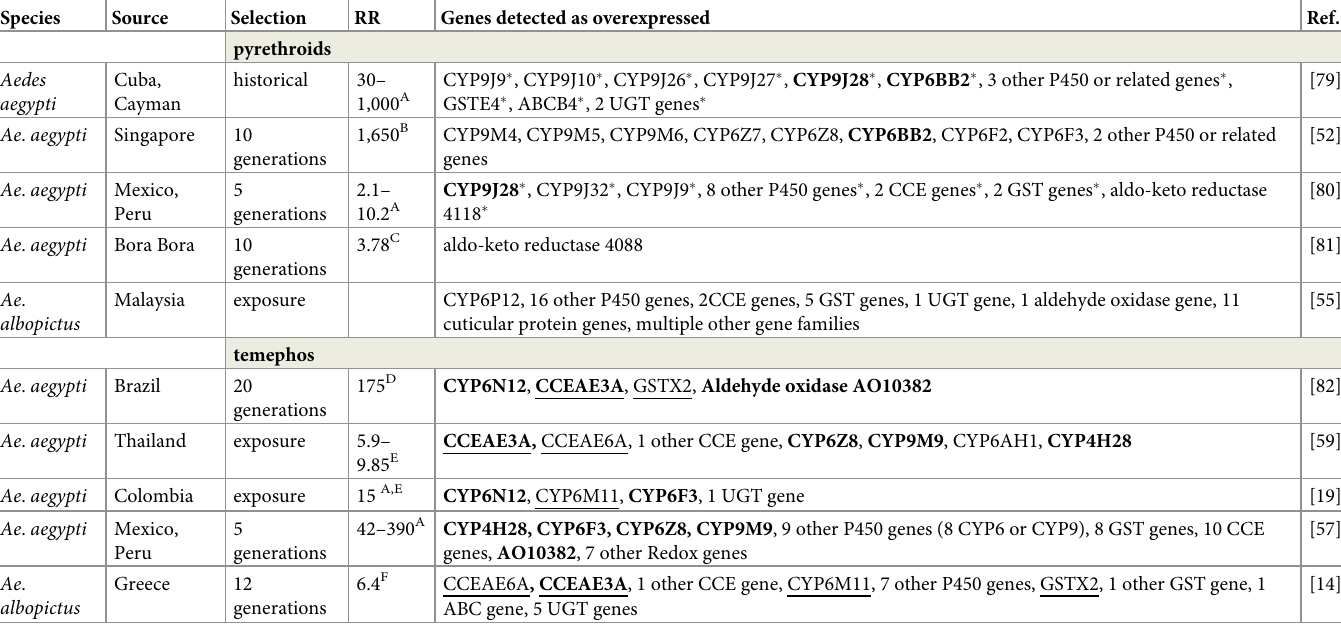
Table 2. The main genes identified by transcriptomic studies specifically targeting expression responses to insecticide selection or exposure.